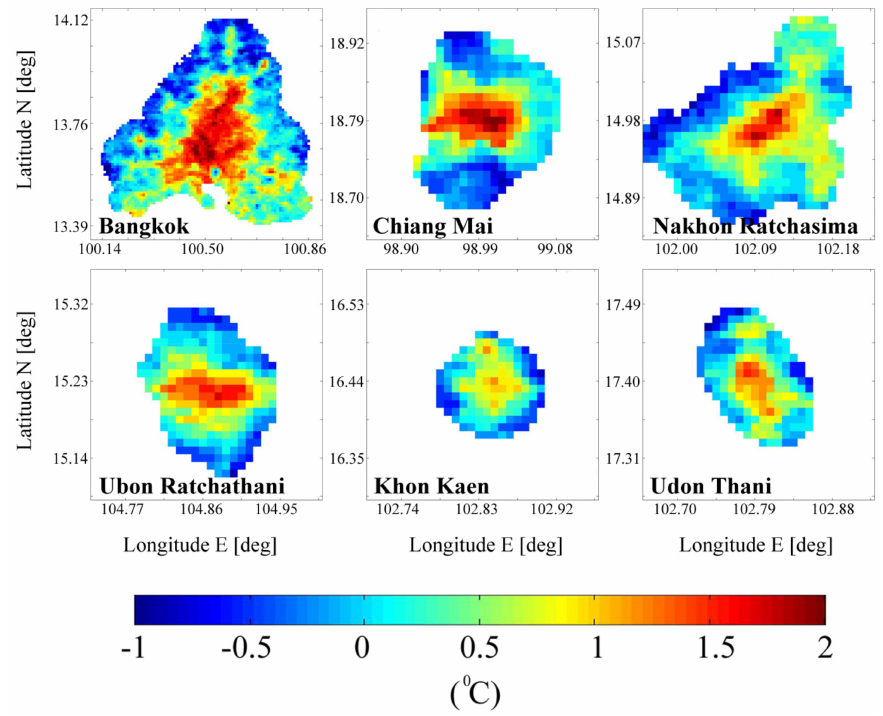
Figure 4. Surface urban heat island (SUHI) during summer 2013 for the six cities at